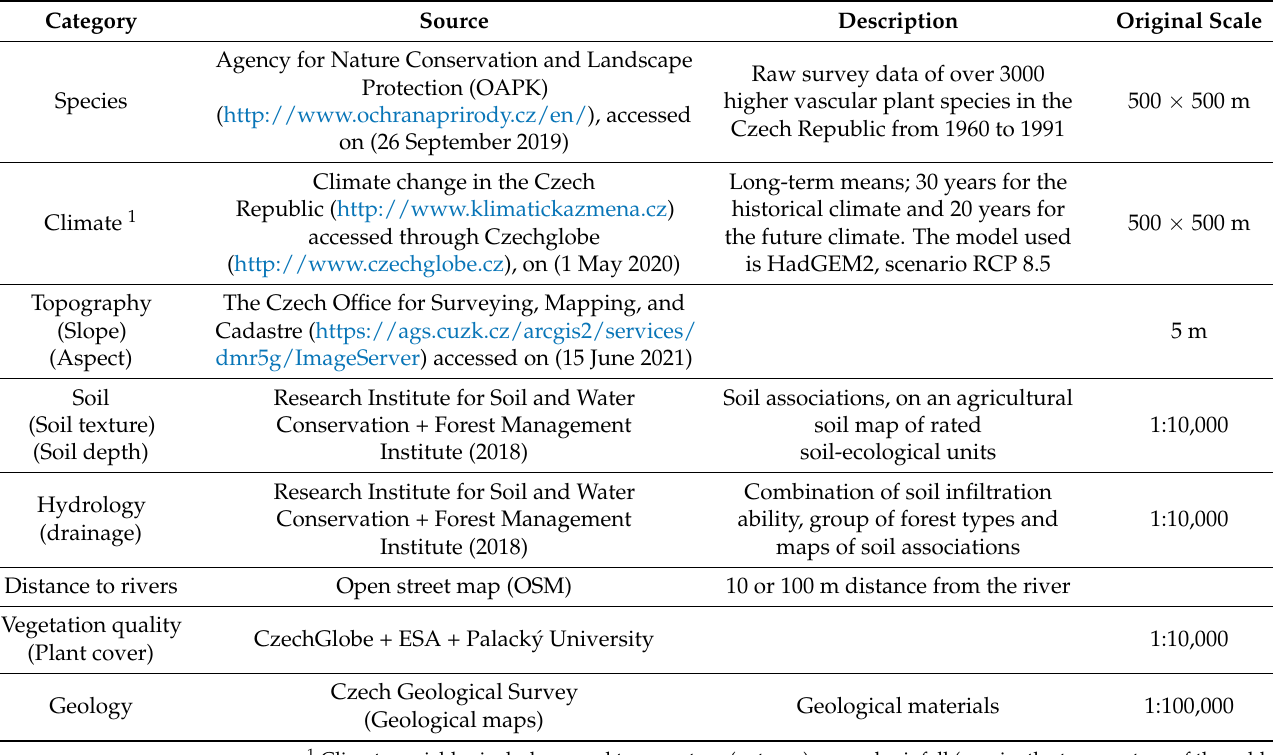
Table 1. Summary of research